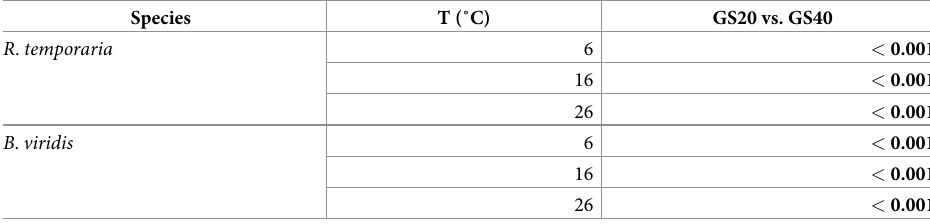
Table 2. Comparison of Folpan 1 500 SC 48h-LC 50 values between developmental stages. Significant differences after Bonferroni-correction are presented in bold. Species T (˚C) GS20 vs. GS40 R . temporaria 6 < 0.001 16 <